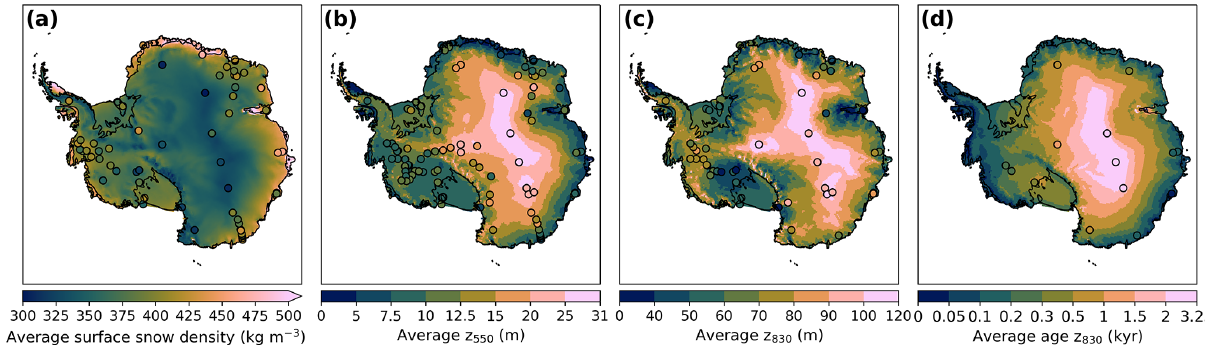
Figure 4. Maps from FDM v1.2A of the average (a) surface snow density (defined as the top 0.5m), depths of critical density levels of (b) ρ = 550kgm − 3 ( z 550 ) and of (c) ρ = 830kgm − 3 ( z 830 ) (the firn thickness), and (d) firn age at the critical density level of (c) ρ = 830kgm − 3 . Circles indicate the values found by field measurements.